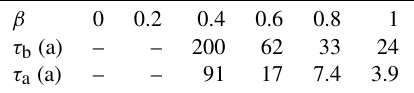
Table 1. Signal retrieval timescales at EDML after precipitation intermittency for the cases of band-pass filtering at a specific fre- quency ( τ b ) and of block averaging to a certain resolution ( τ a ), both as a function of the input climate spectrum scaling exponent β